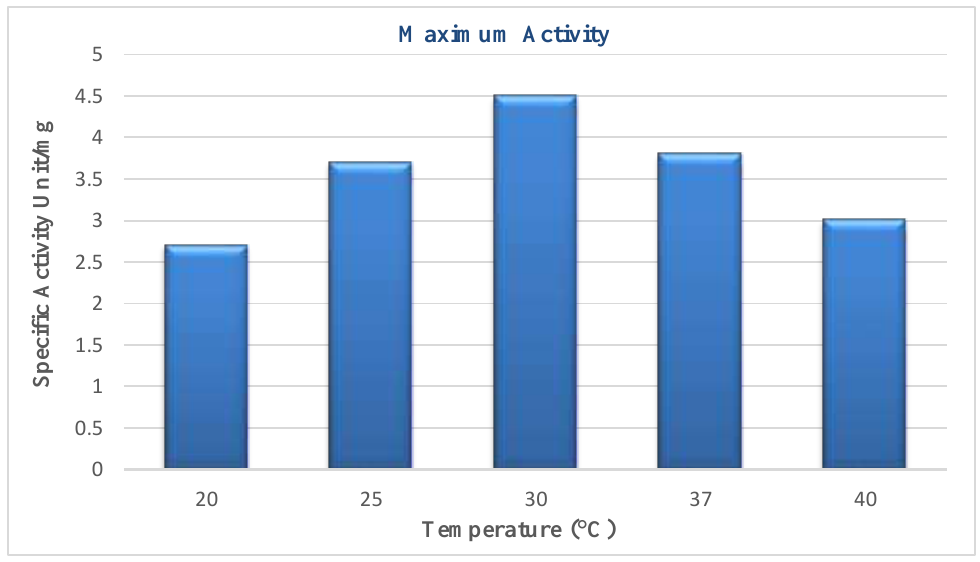
Figure 2. Effect of different ranges of temperatures (20-40) °C on locally isolated L-glutamate oxidase production from Streptomyces